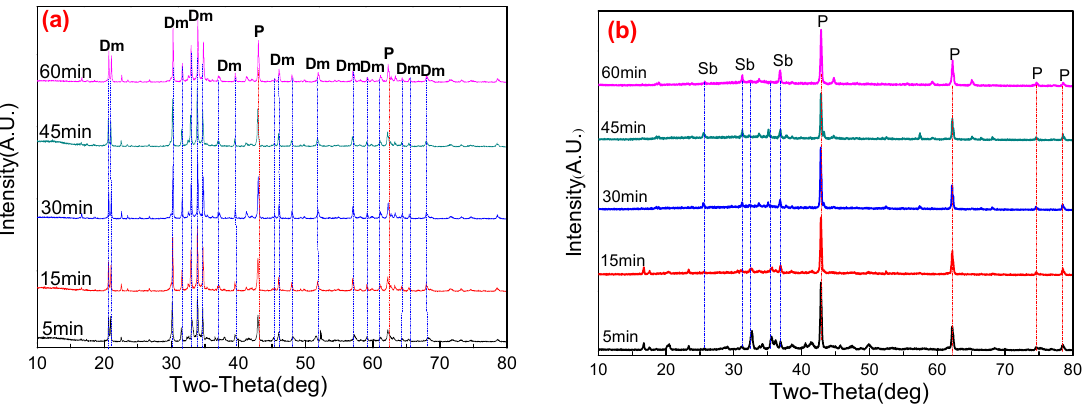
Figure 9. XRD patterns ( a ) mixture of lizardite and sodium carbonate (lizardite to sodium carbonate molar ratio 1:2) and ( b ) mixture of szaibelyite and carbonate (szaibelyite to sodium carbonate molar ratio 1:1) roasted at 1000 °C for a different time in nitrogen atmosphere. Dm—Disodium magnesiosilicate (Na 2 MgSiO 4 ); P—Periclase (MgO); Sb—Sodium borate.